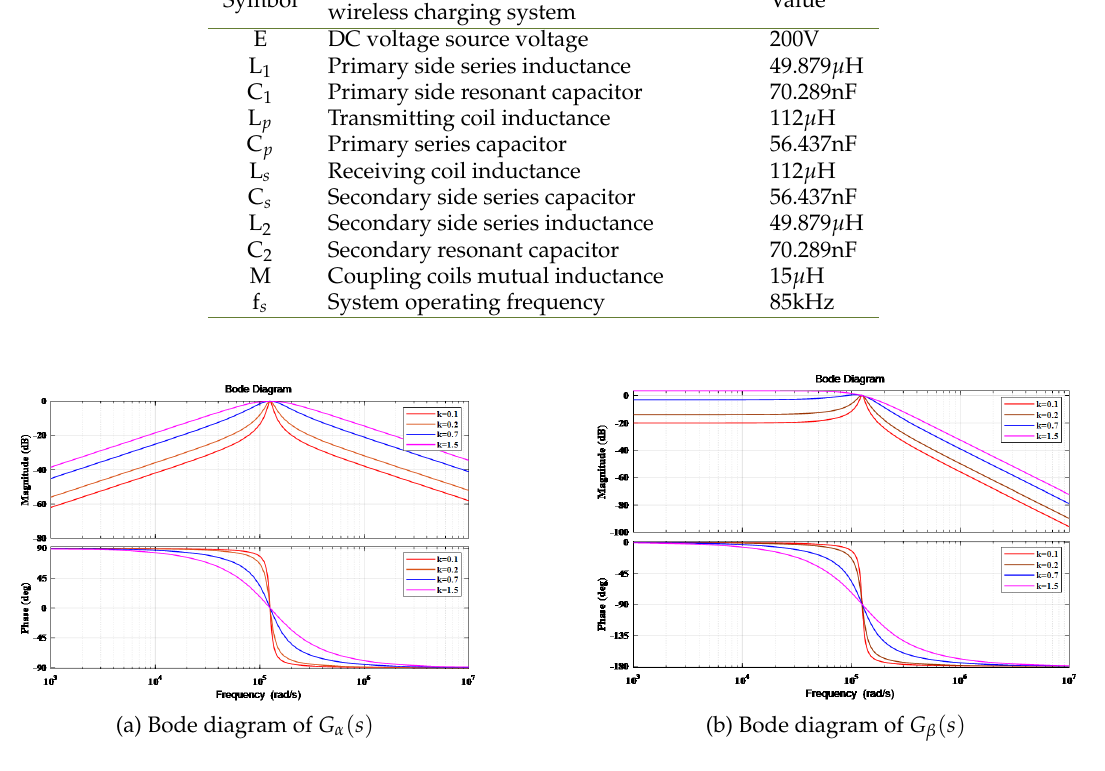
Fig. 8. Bode diagram of G α ( s ) & G β ( s ) Table 4. Controller parameters used in simulation Table 5. Constant current control performance index